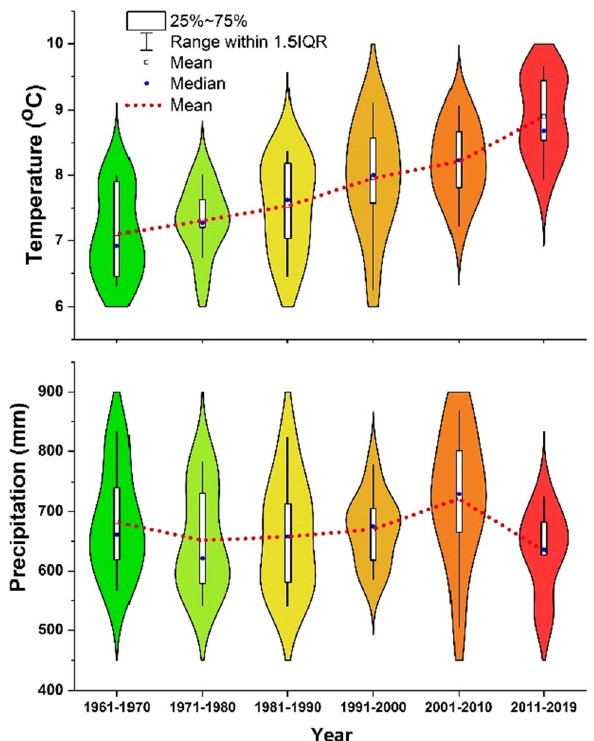
Figure 3. Precipitation and temperature at each decade in the Czech Republic during 1961–2019. The violin plot with boxplot shows both the distribution of the data and its summary statistics (mean/median and interquartile